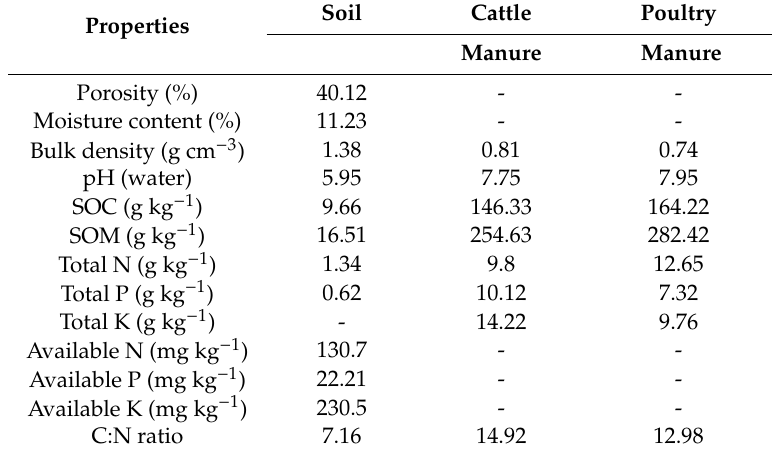
Table 2. Physical and chemical properties of soil and manure before the experiment.